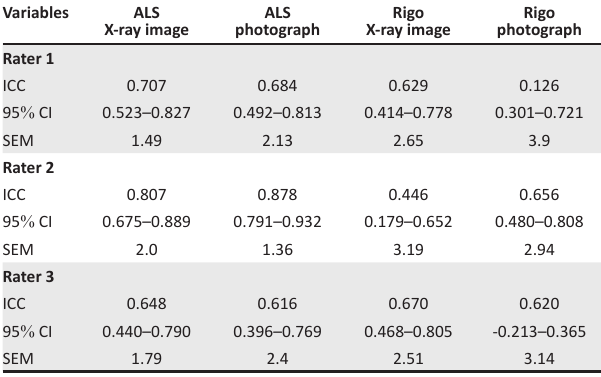
TABLE 2 : Intra-observer reliability reliability analysis for augmented Lehnert- Schroth classification and Rigo